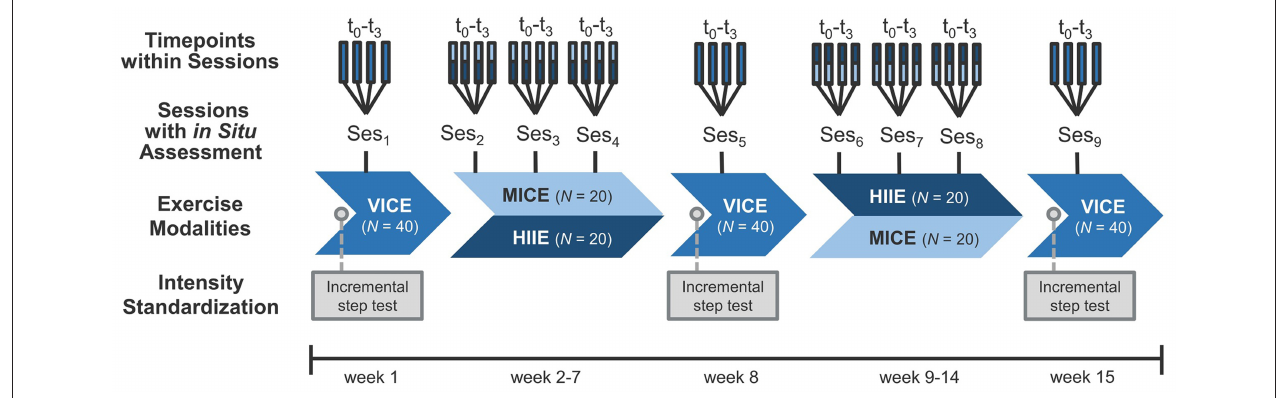
FIGURE 1 | Overview of the within-subject design. In situ assessments were conducted at 4 time points (t 0 -t 3 ) within 3 exercise sessions per exercise modality (VICE, vigorous-intensity continuous exercise; MICE, moderate-intensity continuous exercise; HIIE, high-intensity interval exercise; Ses 1 − 9 ), resulting in a total number of 36 observations per participant ( N = 40). In laboratory visits at weeks 1, 8, and 15, exercise intensities were standardized using an incremental step test with lactate diagnostics and spiroergometry.